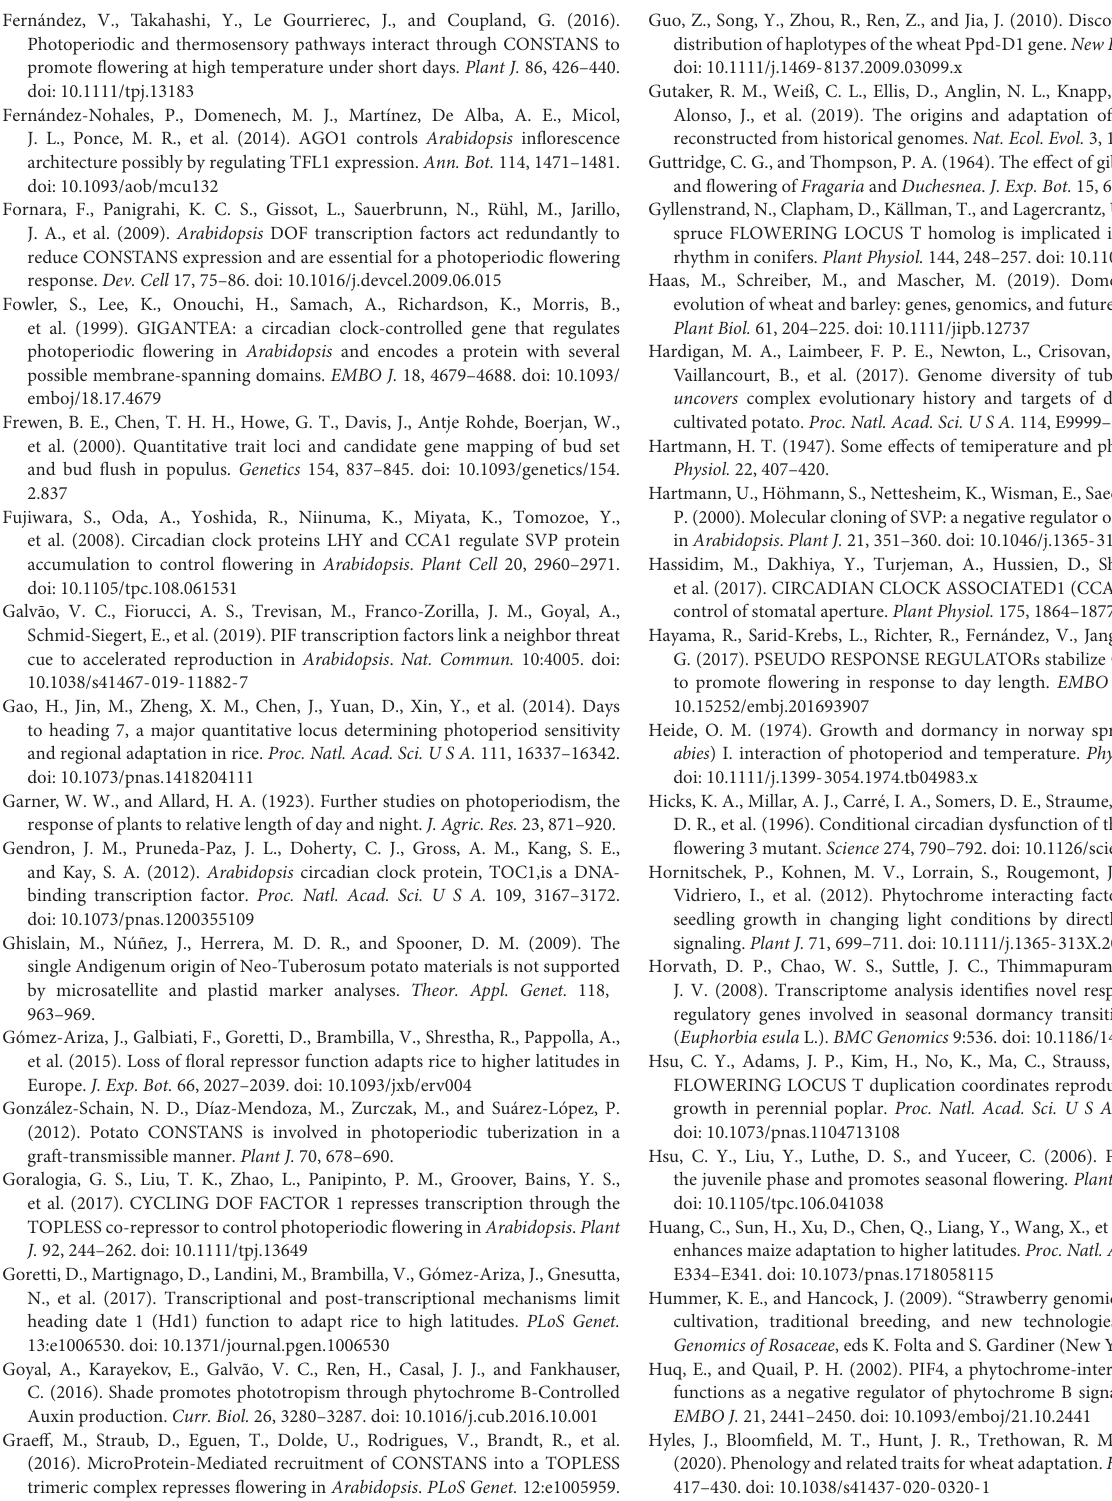
heading date 1 (Hd1) function to adapt rice to high latitudes. PLoS Genet. 13:e1006530. doi: